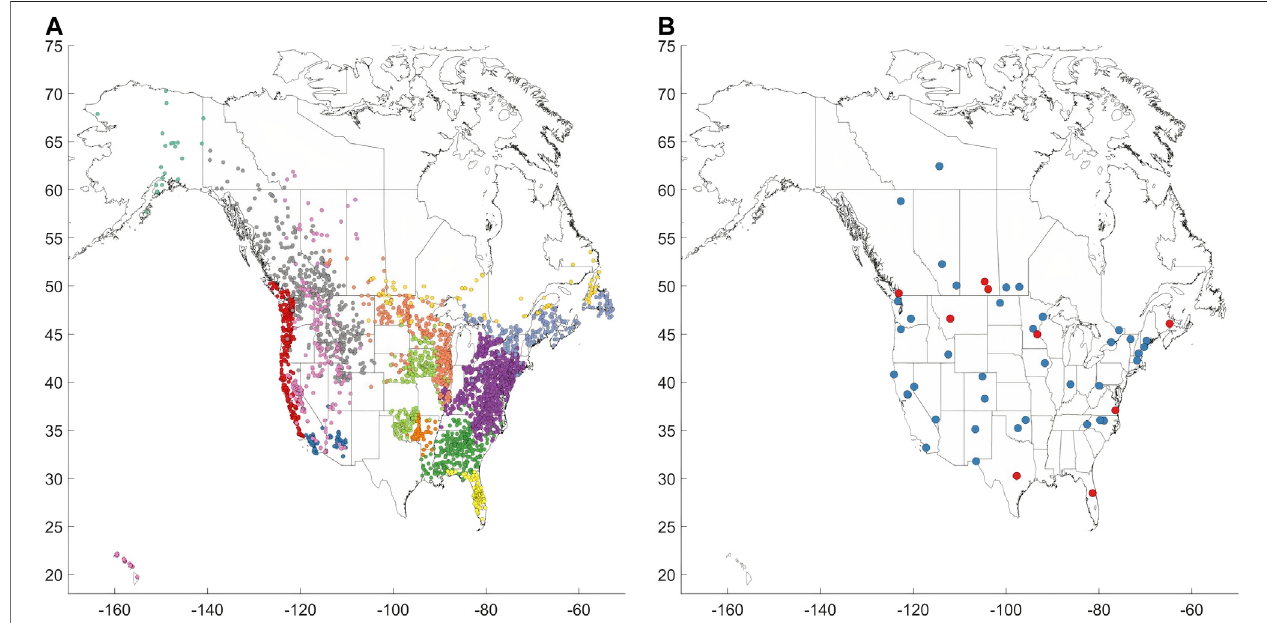
FIGURE1| Mapoflocalitieswith (A) stream fl owdata(4,290gauges),and (B) waterconsumptiondata(47cities).In (A) eachstationdotiscoloredaccordingtothe cluster it belongs to (see Clustering section). In (B) blue and red indicate daily and monthly data, respectively. Some of the city of fi cials asked to keep their cities anonymous, so this map is meant to keep the city names anonymous while showing the spatial extent of the data.